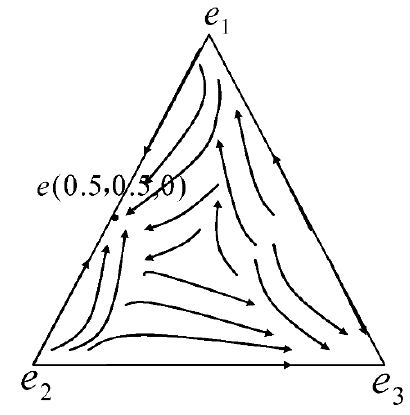
Figure 1. Phases of indirect reciprocity evolution.